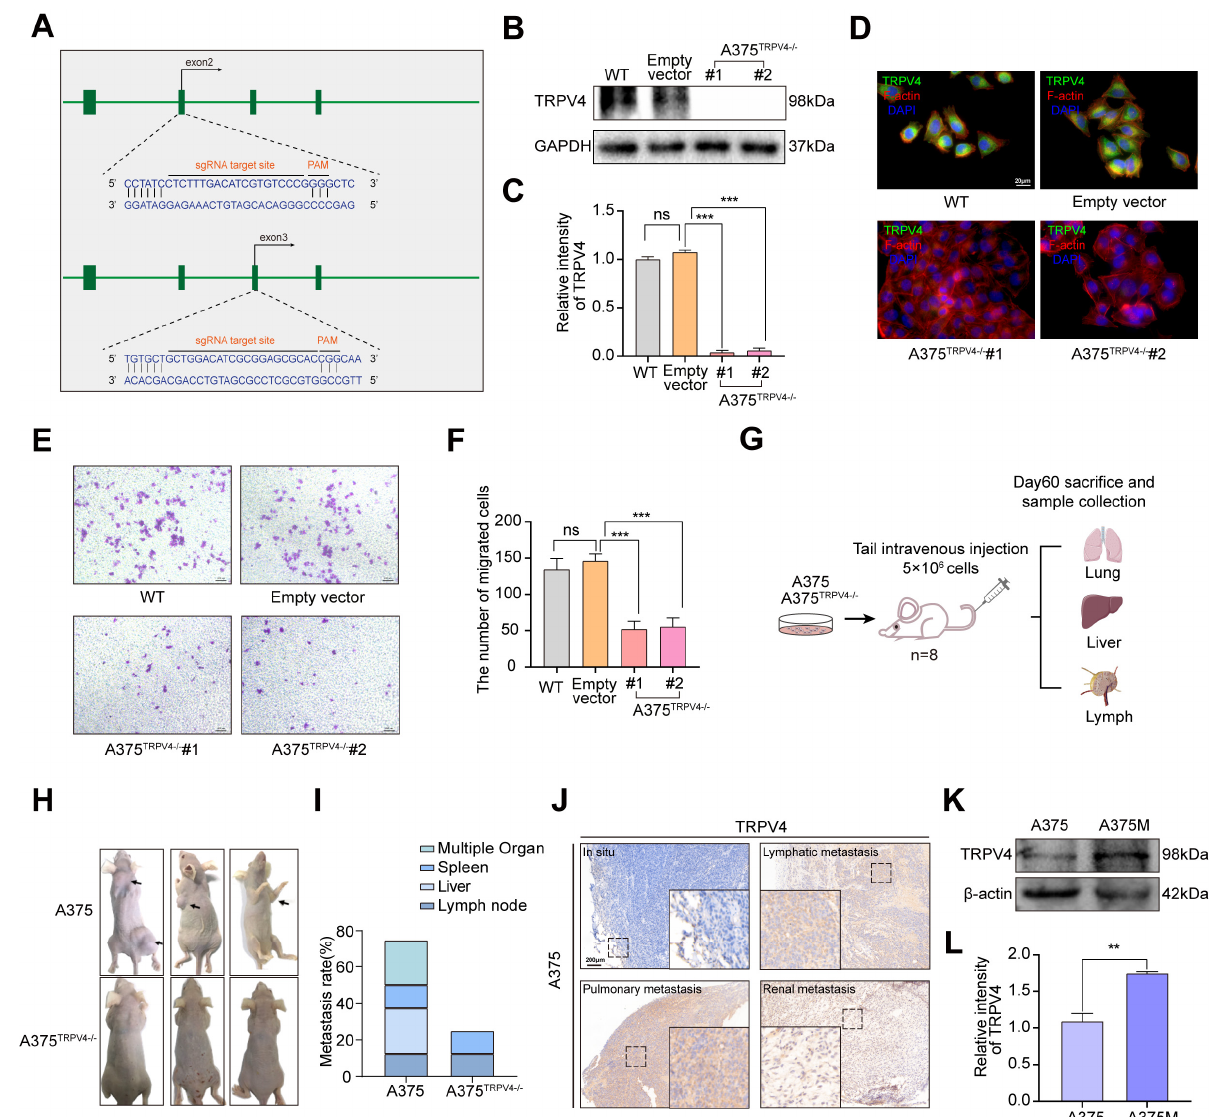
HCT116). 400 × . Scale bar, 20 µ m. ( E ) Calcium imaging of HaCaT, A375, SK-mel-24, and Malme-3M cells treated with 2 nM GSK1016790A (n = 6, each group). ( F ) BALB/c-Nude mice were s.c. engrafted with 5 × 10 6 A375 cells. ( G ) Representative images of HE and IHC (TRPV4) in tumor and normal skin tissues. 40 × . Scale bar, 200 µ m. ( H ) Survival cox regression data for TRPV4 from SKCM patients using OncoLnc ( p -value = 0.0176). Data are expressed as means ± SD.